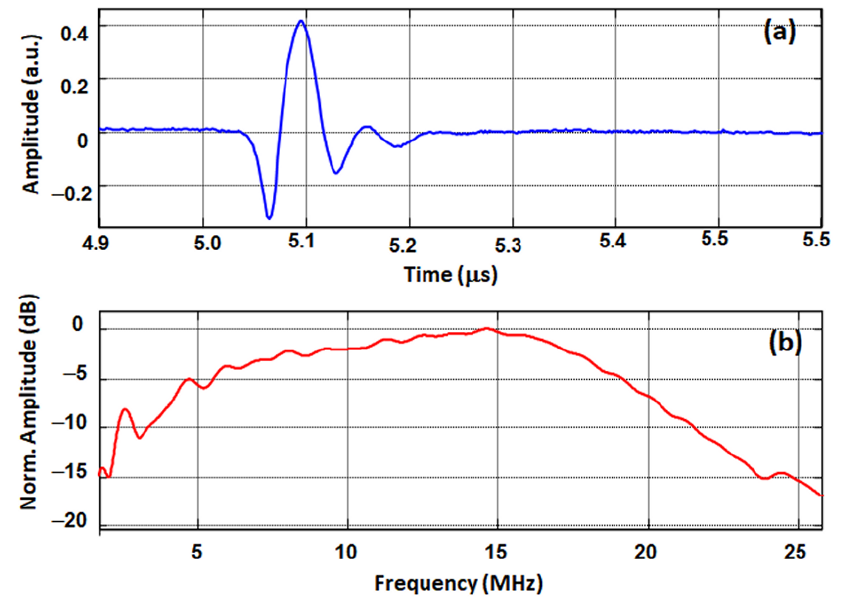
Figure 7. Experimental ( a ) time and ( b ) frequency responses for a KNNSr-T. The KNNSr-T had a sensitivity of − 60 dB and a centre frequency of 15 MHz. The corresponding fractional bandwidth (BW) was very high, with a value of 127% at − 6 dB. Note that for the pulse-echo measurements of the KNNSr-T, the beam was not focused as is the case with other transducers [11,32]. Larger sensitivities were measured for focused- beam transducers, i.e., − 31 and − 41 dB for KNN and PZT transducers, respectively, but the BWs were lower, i.e., 42 and 93% at − 6 dB, respectively. The very wide bandwidth of the KNNSr-T provides a large axial resolution, and, in the case of beam focusing, such a structure shows a high potential for imaging